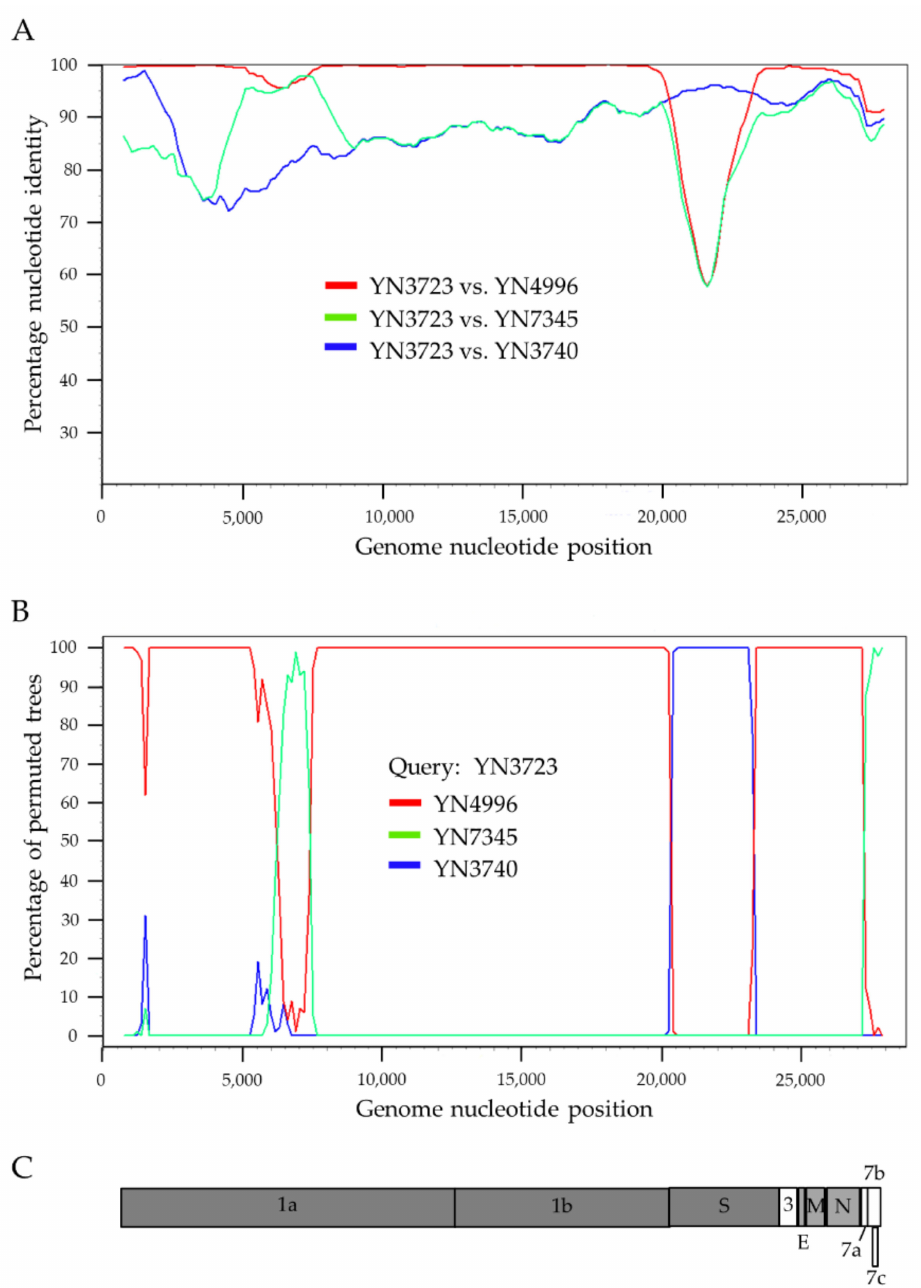
Figure 5. Evidence of recombination in BtCoV HKU10s. Similarity ( A ) (window of 40 nt, step size of 40 nt) and recombination ( B ) (window of 1500 nt, step size of 150 nt) plots were generated using Simplot (V3.5.1) with default settings. Full-length genome sequence of YN3723 was used as query sequence and YN3740, YN4996 and YN7345 as reference sequences. All analyses were performed with Kimura model, a window size of 1500 base pairs, and a step size of 150 base pairs. The map of query genome sequences ( C ) are used to position